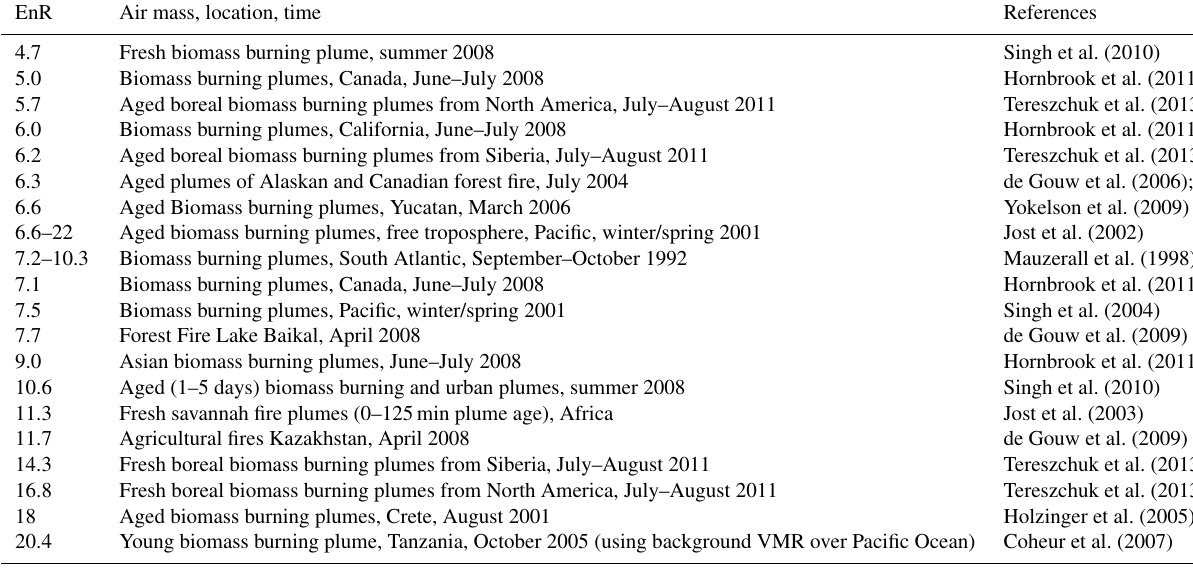
Table 2. Literature values of acetone–CO enhancement ratios (EnRs) in biomass burning plumes in pptppb − 1 . EnR Air mass, location,